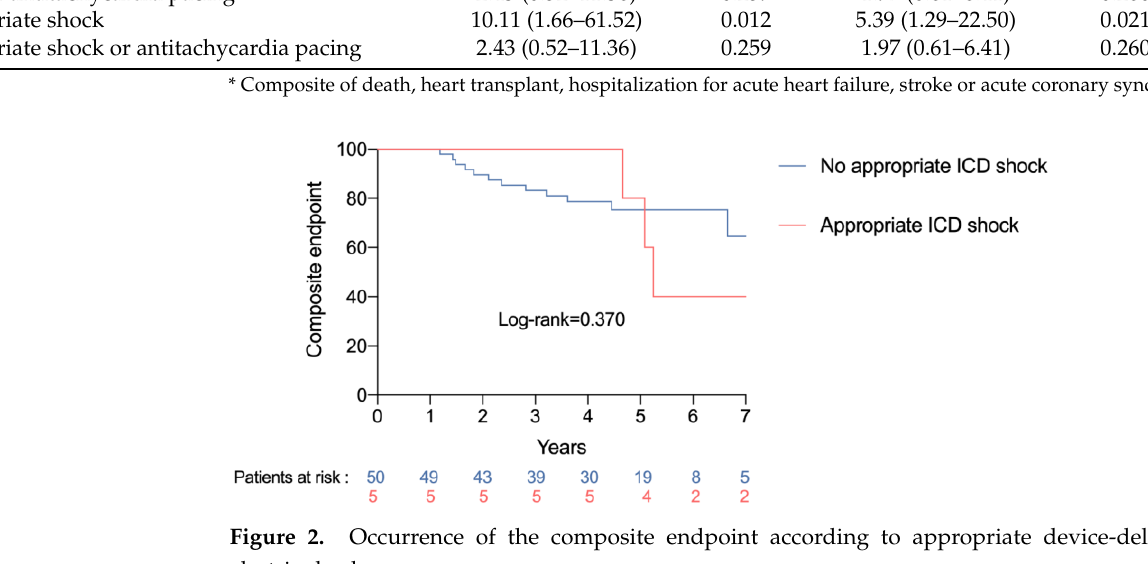
electric shock. shock.